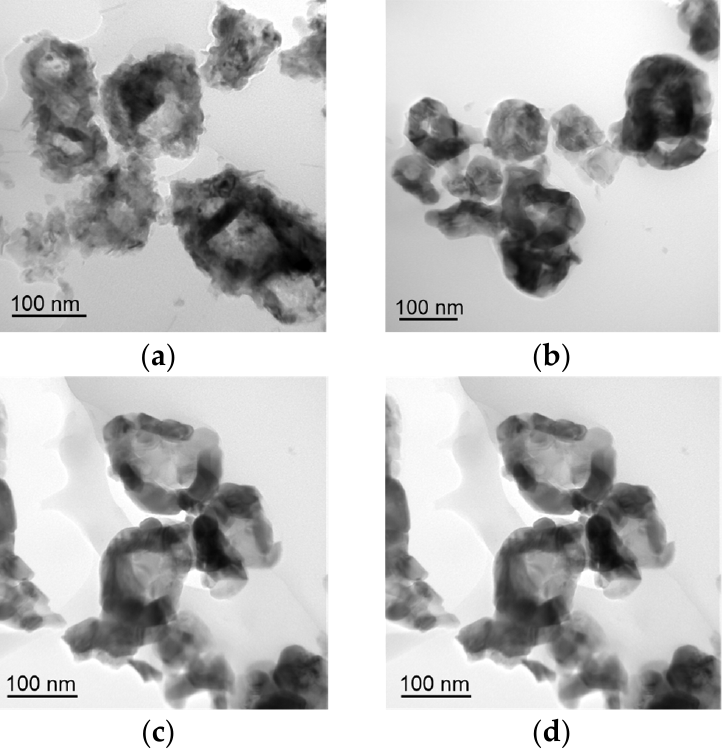
Figure 4. TEM images of the nanoparticles obtained after heating Co nanoparticles up to 250 ° С ( a ), 300 ° С ( b ), 450 ° С ( c ), and 600 ° С ( d ).